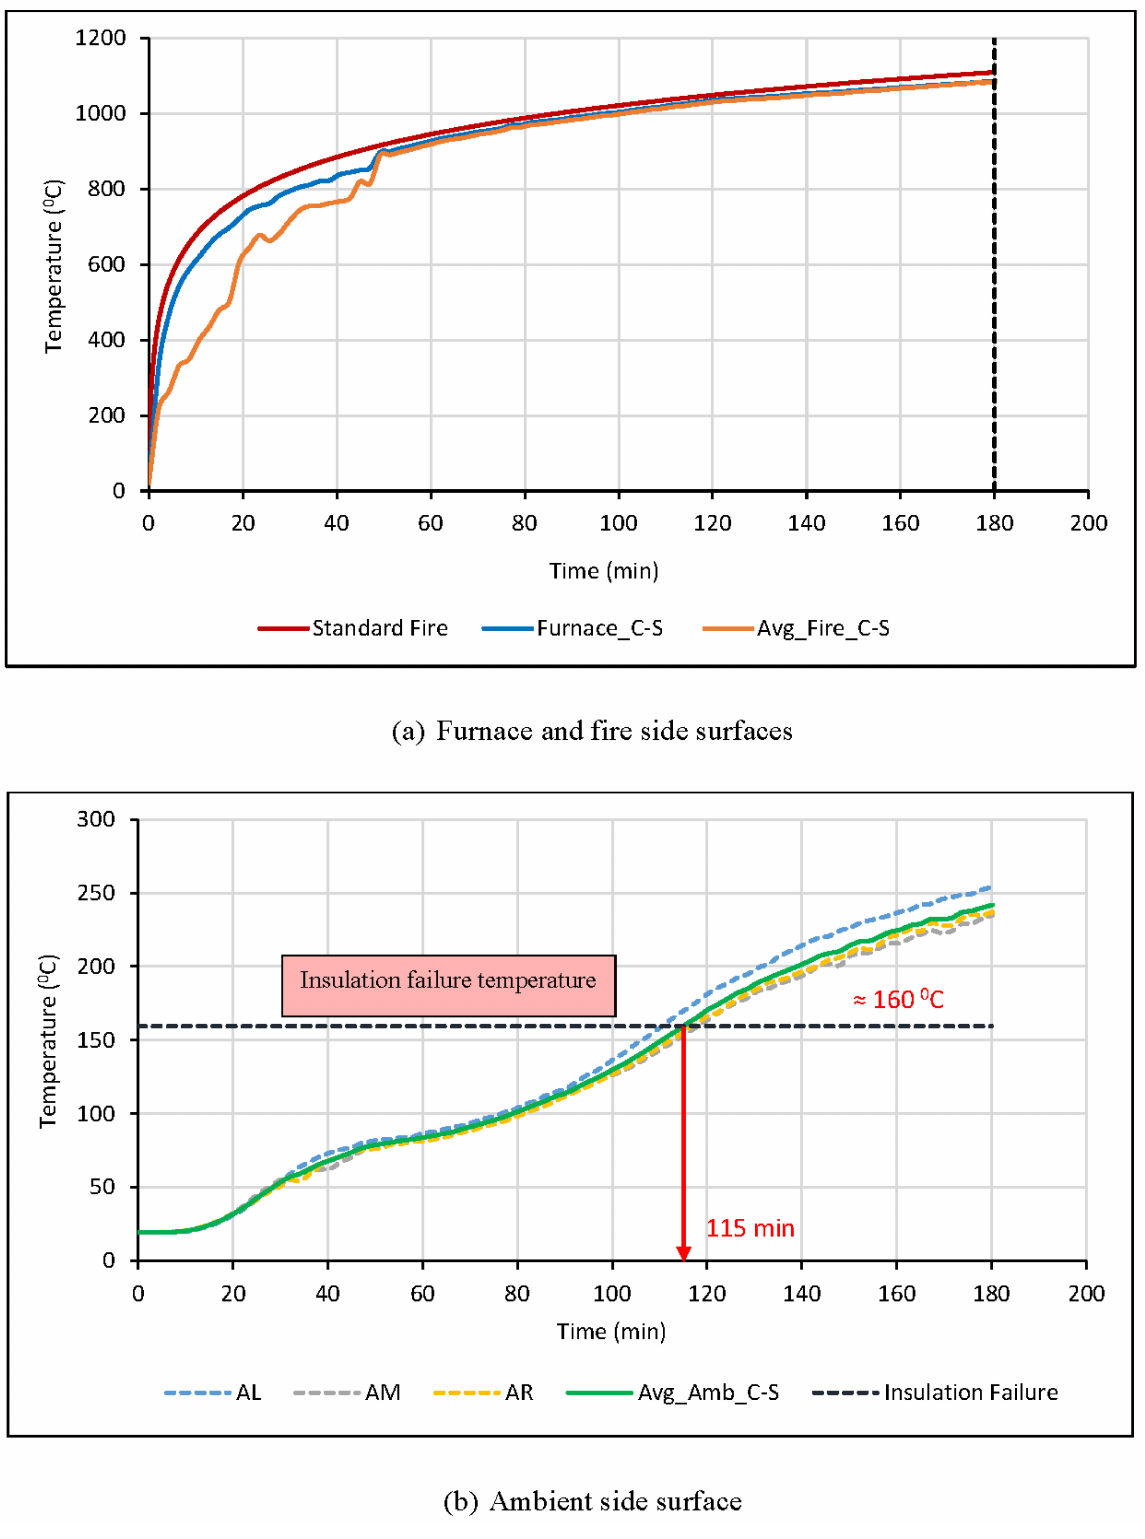
Figure 18. Time–temperature curves of C-S block from the building fire